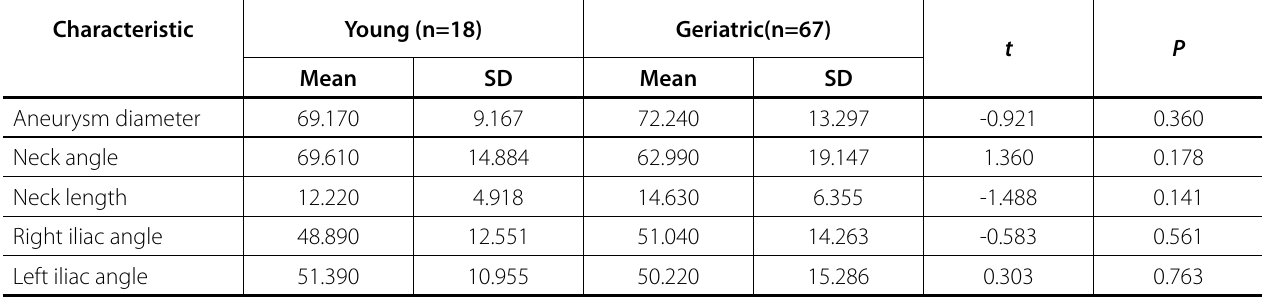
Table 4 . Patients’ averages by age.